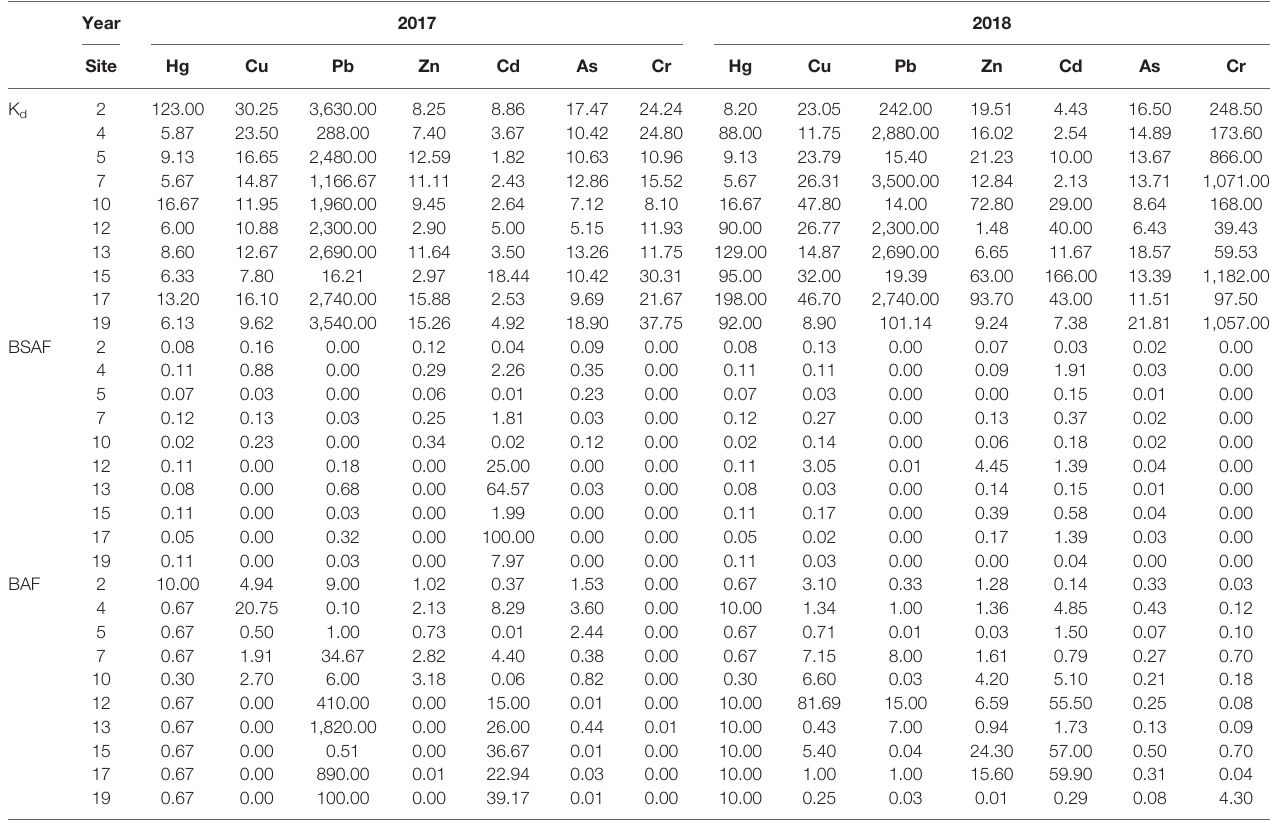
TABLE 2 | Partitioning and bioaccumulation index in coastal